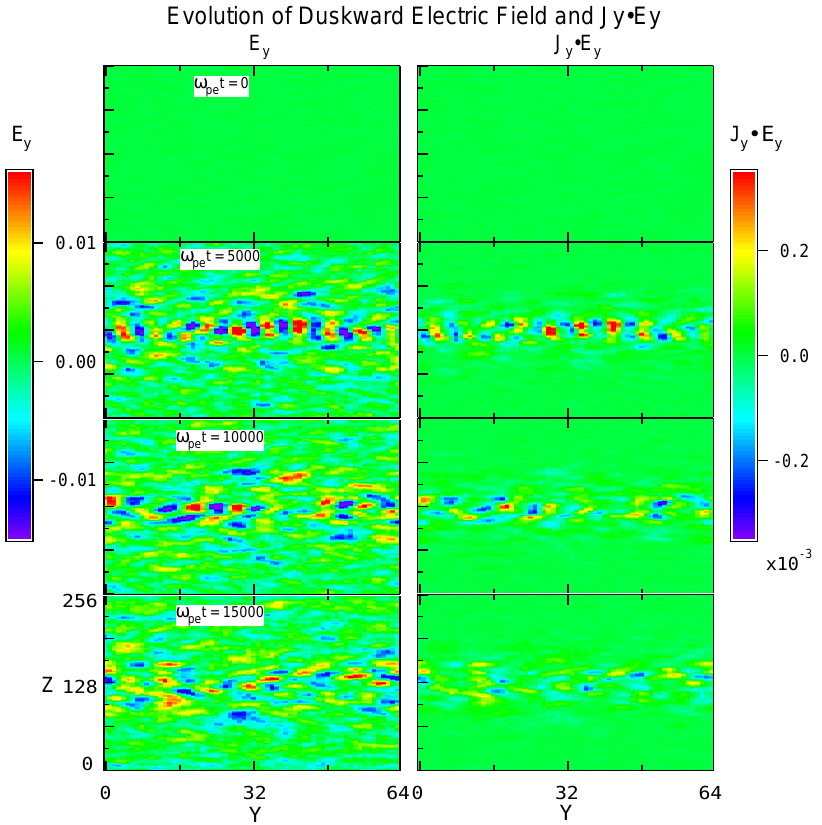
Fig. 8. Evolution of current density and the current dissipation/dynamo term in 2-1/2D particle simulation of current disruption (Lui, 2004). Each panel shows a yz -plane cut of the current sheet. As time progresses, the initial relatively uniform current density breaks up, exhibiting both dissipation ( j y E y > 0) and dynamo effect ( j y E y <